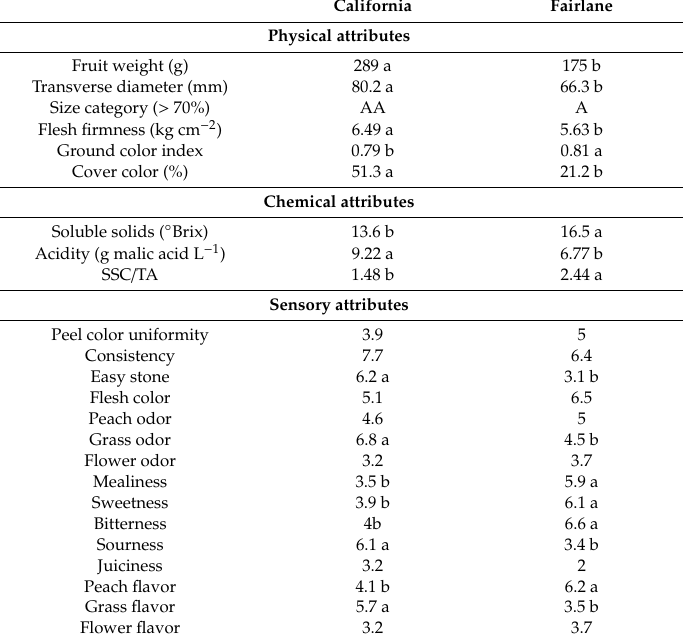
Table 3. Physical, chemical ( n = 30), and sensory ( n = 20) attributes for the two nectarine cultivars grown (500 trees / ha) near Riesi (37 ◦ 16 (cid:48) N and 330 m a.s.l.), in central–southern Sicily. Physical and chemical attribute assessments were done within a day from harvest. Di ff erent letters indicate significant di ff erences ( t -test, p < 0.05) between the cultivars and for each